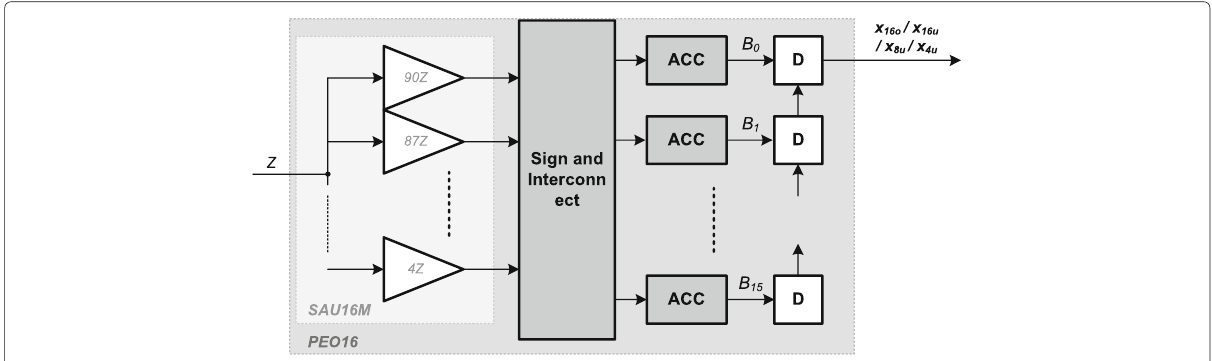
C 16e Z 16e , 8-point C 8e Z 8e , and 4-point C 4e Z 4e by sup- porting variable transform sizes (32-, 16-, 8-, and 4-point matrix products). Thus, x 16o , x 16u , x 8u , and x 4u can be obtained from PEO16 according to the adaptive transform